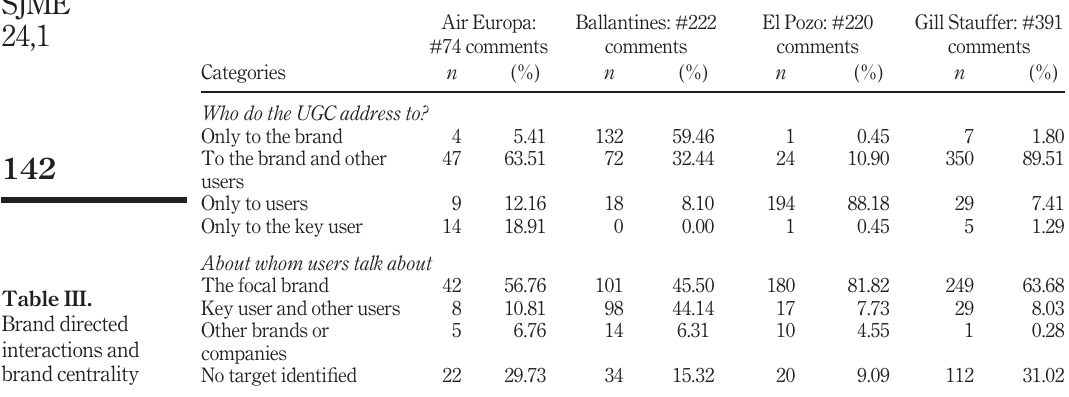
Table III. Brand directed interactions and brand